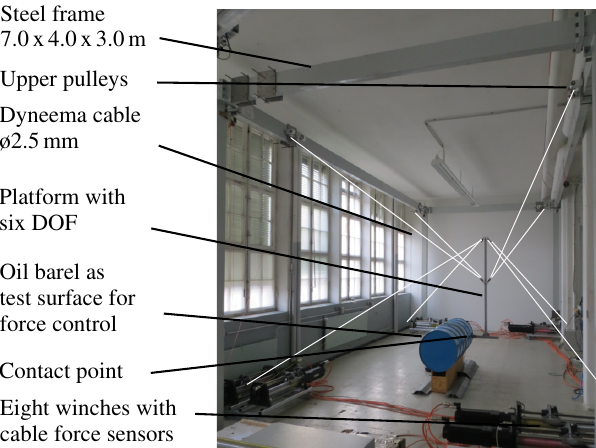
Figure 1. Cable-driven parallel robot IPAnema 3: Robot test set-up. respectively. With the selection matrix S , the degrees-of- freedom (DOF) are assigned to be either force or position controlled. The hybrid control law was implemented already on parallel manipulators in Madani and Moallem (2011) and Deng et al. (2010). For the cable robot, several adaptions are made. The major difference to the classic hybrid control law is the additional cable force control loop to control the inter- nal cable tensions. For a serial robot, the concept of an ad- ditional null-space control loop is described in Park